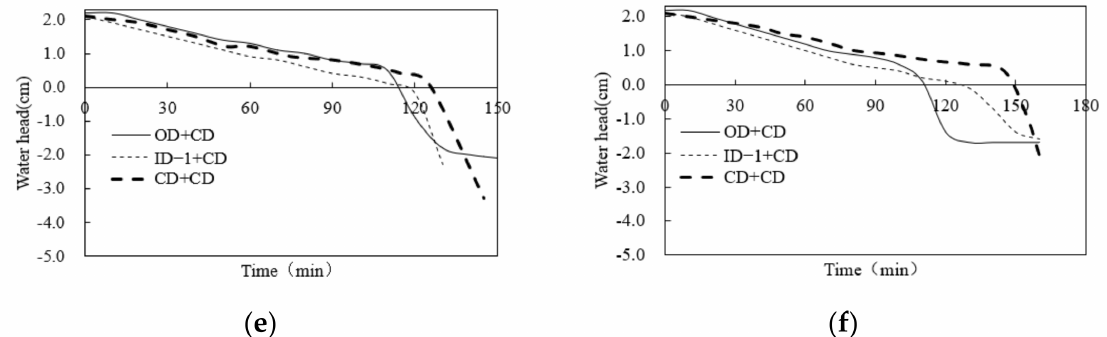
Figure 7. Flooding and waterlogging removal effect under different combined drainage forms; ( a ) Deep–deep combination; ( b ) Medium–deep combination; ( c ) Medium–medium combination; ( d ) Shallow–deep combination; ( e ) Shallow–medium combination; ( f ) Shallow–shallow combination.